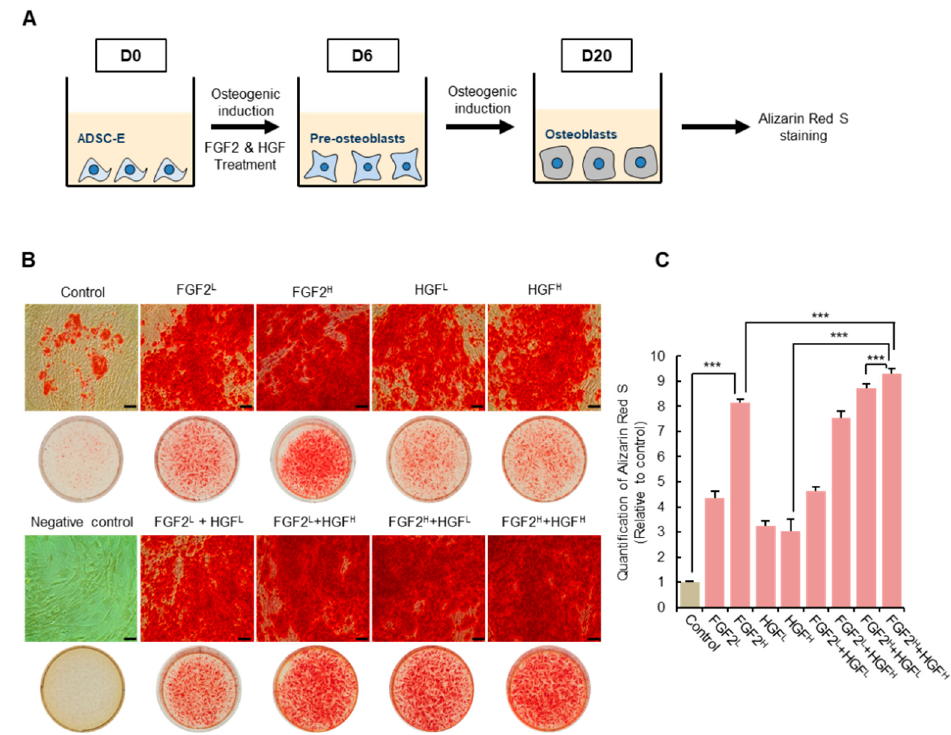
Figure 3. FGF-2/HGF priming enhances the osteogenic potential of ADSC-E. ( A ) Experimental schedule to treat ADSC-E with FGF2 and/or HGF during the osteo-inductive condition. ( B , C ) Representative images of Alizarin Red S staining of ADSC-E in each condition and the quantification of calcium deposition. Scale bar, 100 μ m. Results are shown as the mean ± SD of four replicate wells for each group. *** p < 0.001. FGF2 L : 1ng/mL, FGF2 H : 5 ng/mL, HGF L : 10 ng/mL, HGF H : 50ng/mL.